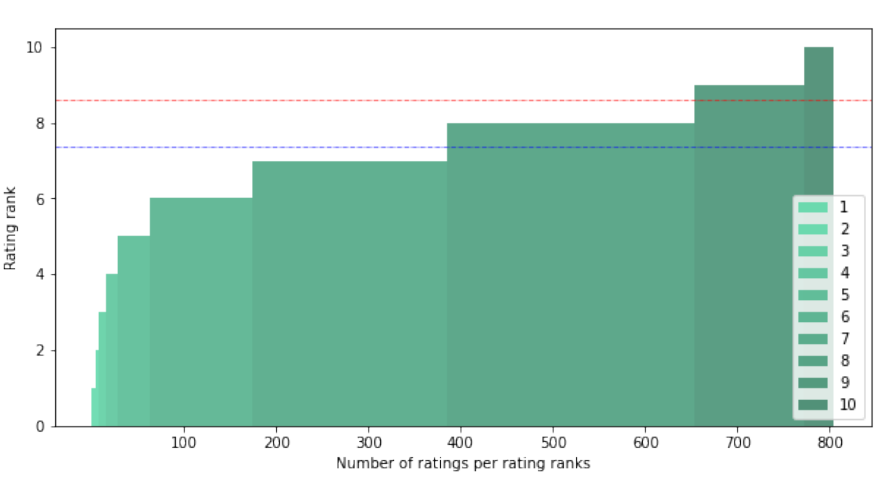
Figure 7. User rating distribution in comparison with the average of the recommended items (red) and the item rating average from the user